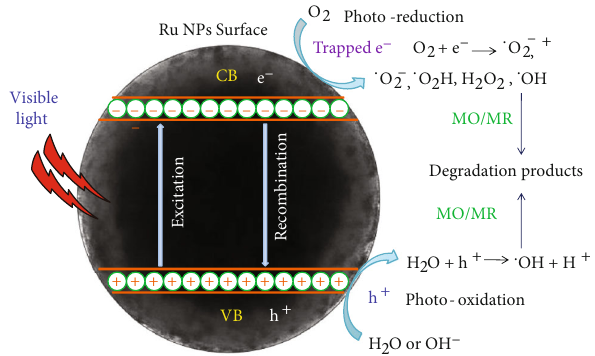
Figure 14: Mechanism of photocatalytic degradation of MO/MR dyes by Fe O @SiO @Ru HMCs. 3 4 2